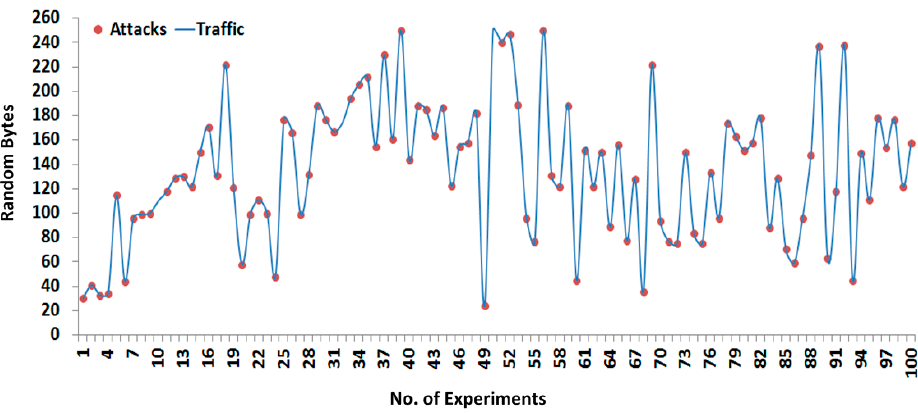
Figure 11. Attacks: Main controller traffic.